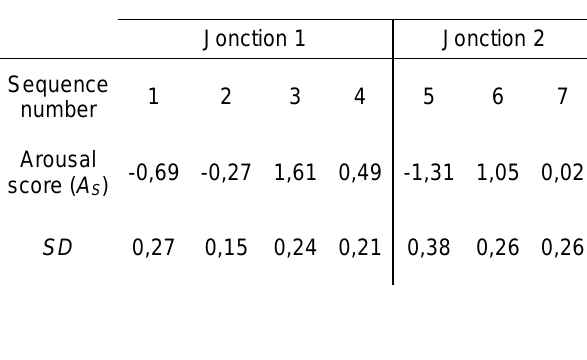
Table 1. Mean arousal scores for the selectable